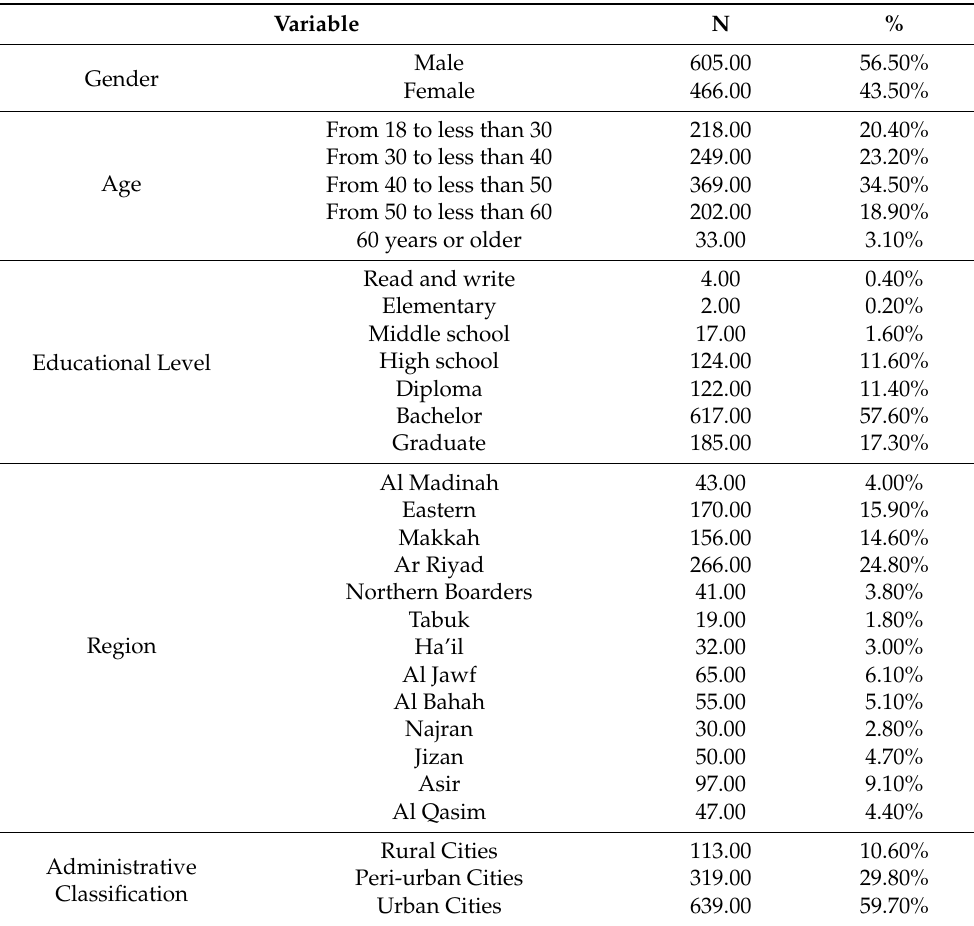
Table 1. Demographic Characteristics.